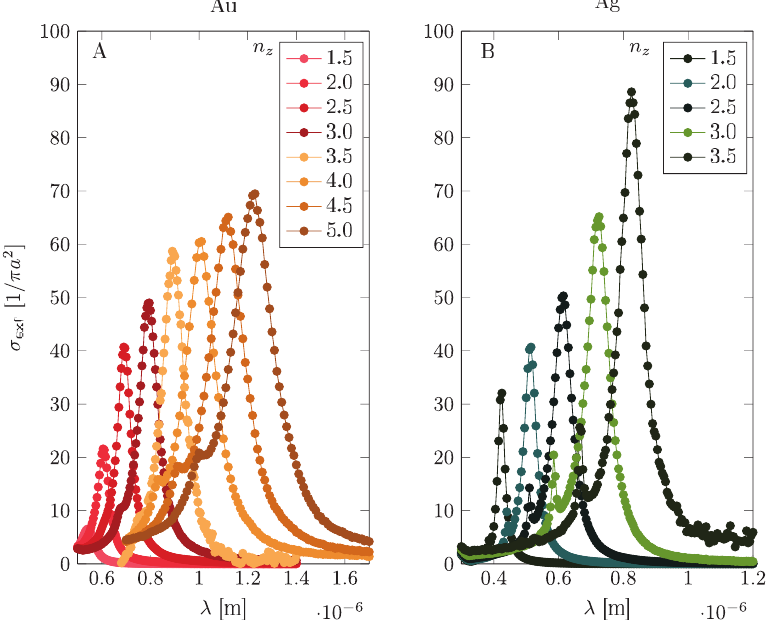
Figure 3. The dependence of the surface plasmon resonance (extinction cross-section spectral dependence) with respect to the permittivity ε = n 2 z of the dielectric surroundings ( n z is the refraction index of the dielectric medium, as marked in the figure). The dependence is relatively strong and in the figure shown for Au and Ag nanoparticles with radius a = 20